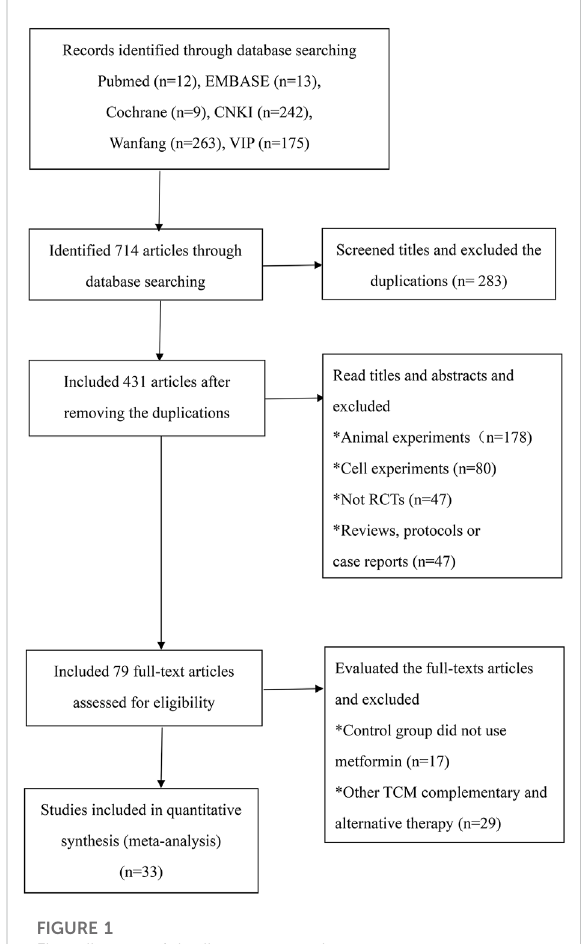
FIGURE 1 Flow diagram of the literature search